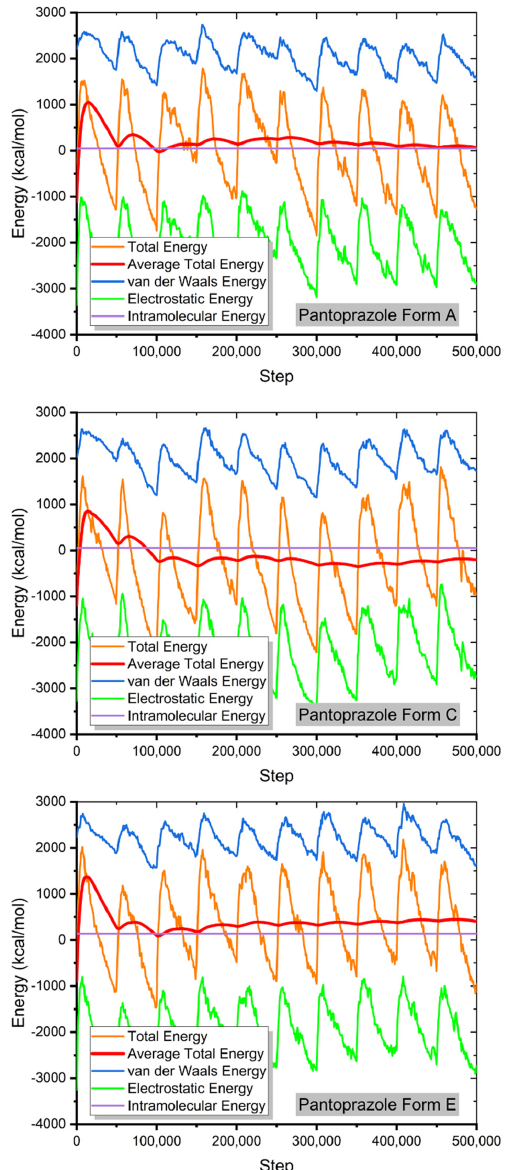
Figure 6. The contribution of the different energy terms during the MC calculations. The results of the Monte Carlo simulations were consistent with those of the experi- ments. Due to the strong negative value of the adsorption energies (as seen in Figure 7), the adsorption process was considered to be spontaneous [11,24,25,33].